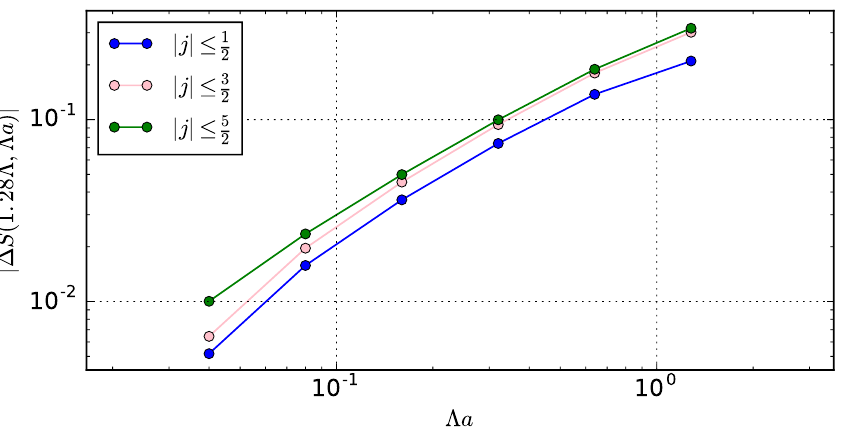
Figure 18 . Plot of the di(cid:11)erence S ((cid:3) j ~x 0 j = 1 : 28 ; (cid:3) a ) (cid:0) S ((cid:3) j ~x 0 j = 1 : 28 ; (cid:3) a = 0 : 01) j , for di(cid:11)erent maximum values of j j j that shows the convergence of this particular value of entropy upon iterative (cid:12)ne-graining of the sampling parameter a . Note how truncating at higher values of j j j does not a(cid:11)ect very noticeably the rate of convergence in a